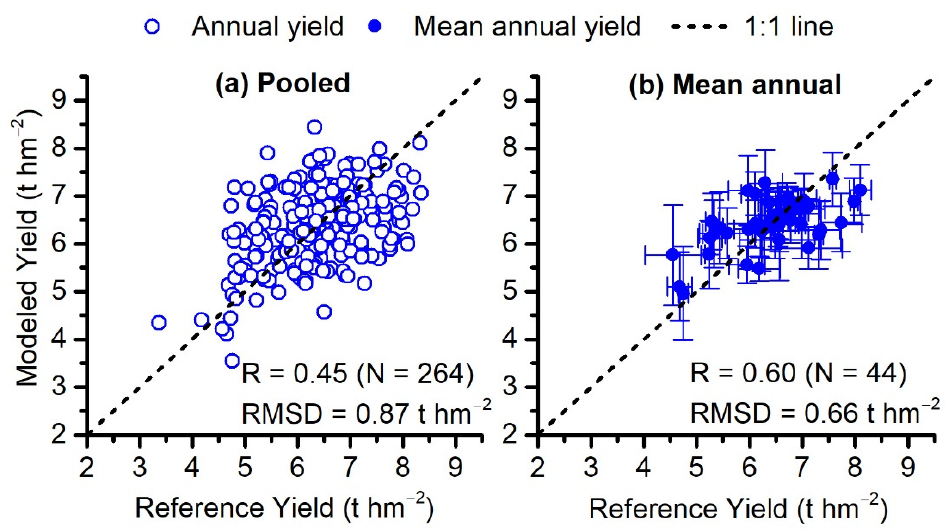
44 samples; the solid line in each scatter plot represents the “1:1 line.” The value ranges in the legend are right-closed and left-open.